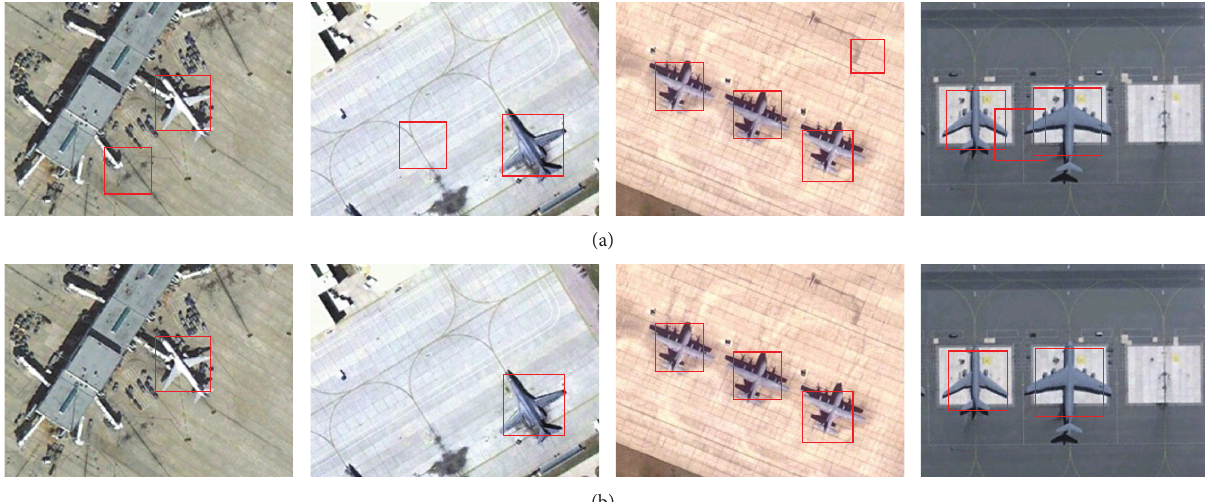
Figure 8: The effectiveness of CF-filter. (a) Detection results without CF-filter; (b) detection results with CF-filter.